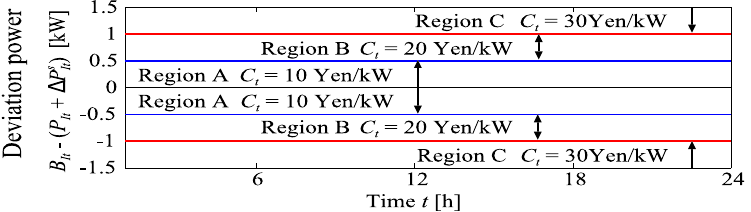
Figure 2. Proposed electricity price